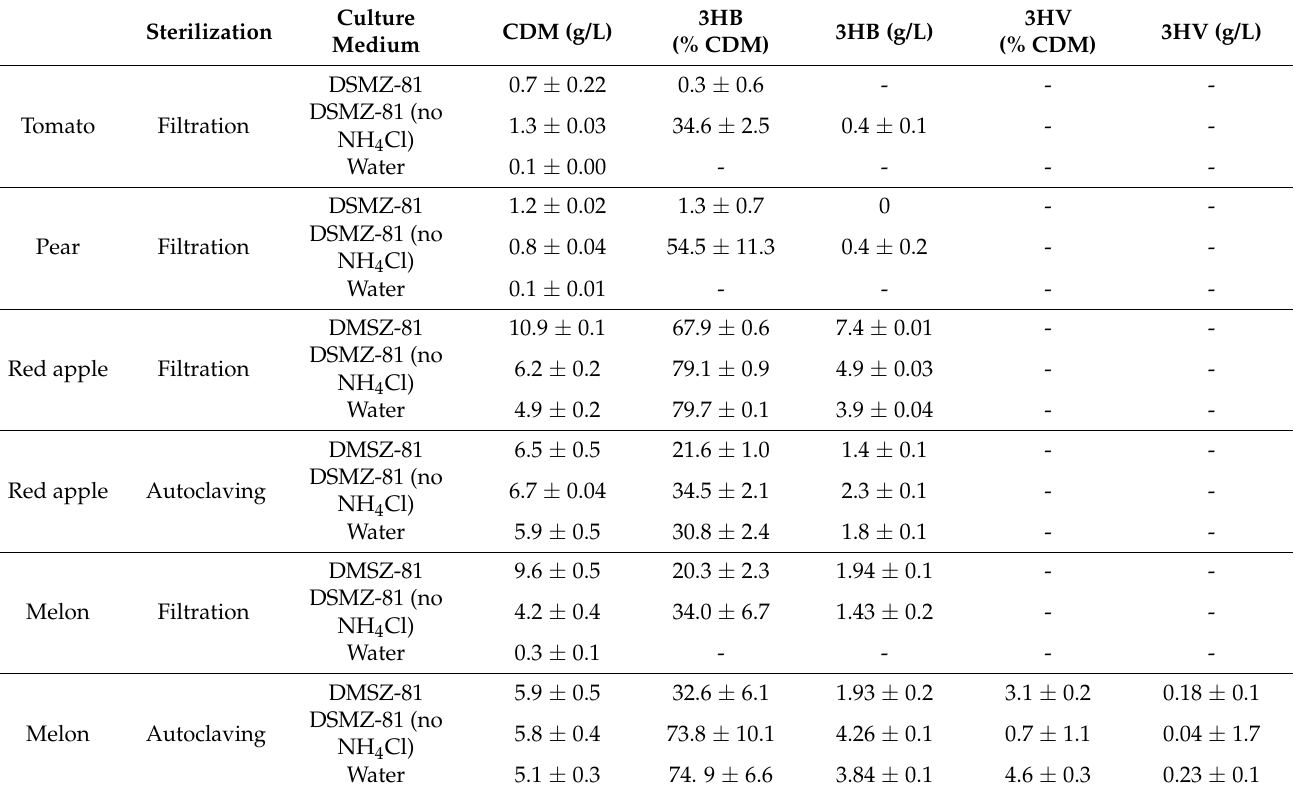
Table 3. Biomass production and 3HB and 3-hydroxybutyrate (3HV) accumulation by C. necator DSM 545 after 96 h from tomato, pear, red apple, or melon as the sole carbon sources. Flasks